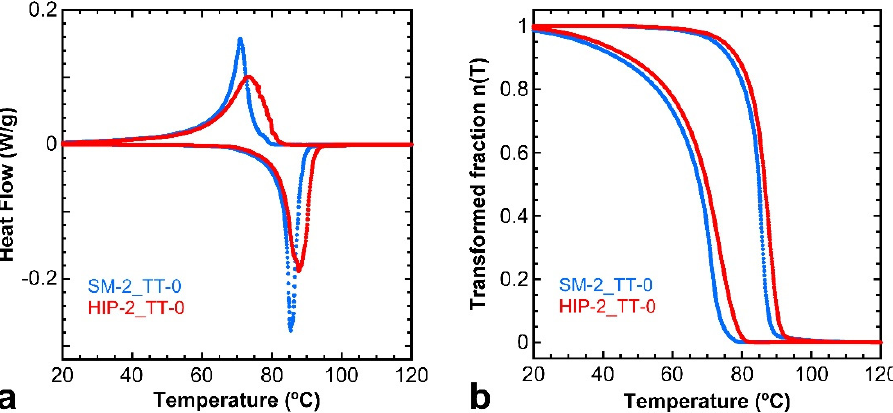
Figure 10. Optical microscopy by interferential contrast of the HIP–1 treated sample. The porosity is dramatically reduced and precipitates are not observed.